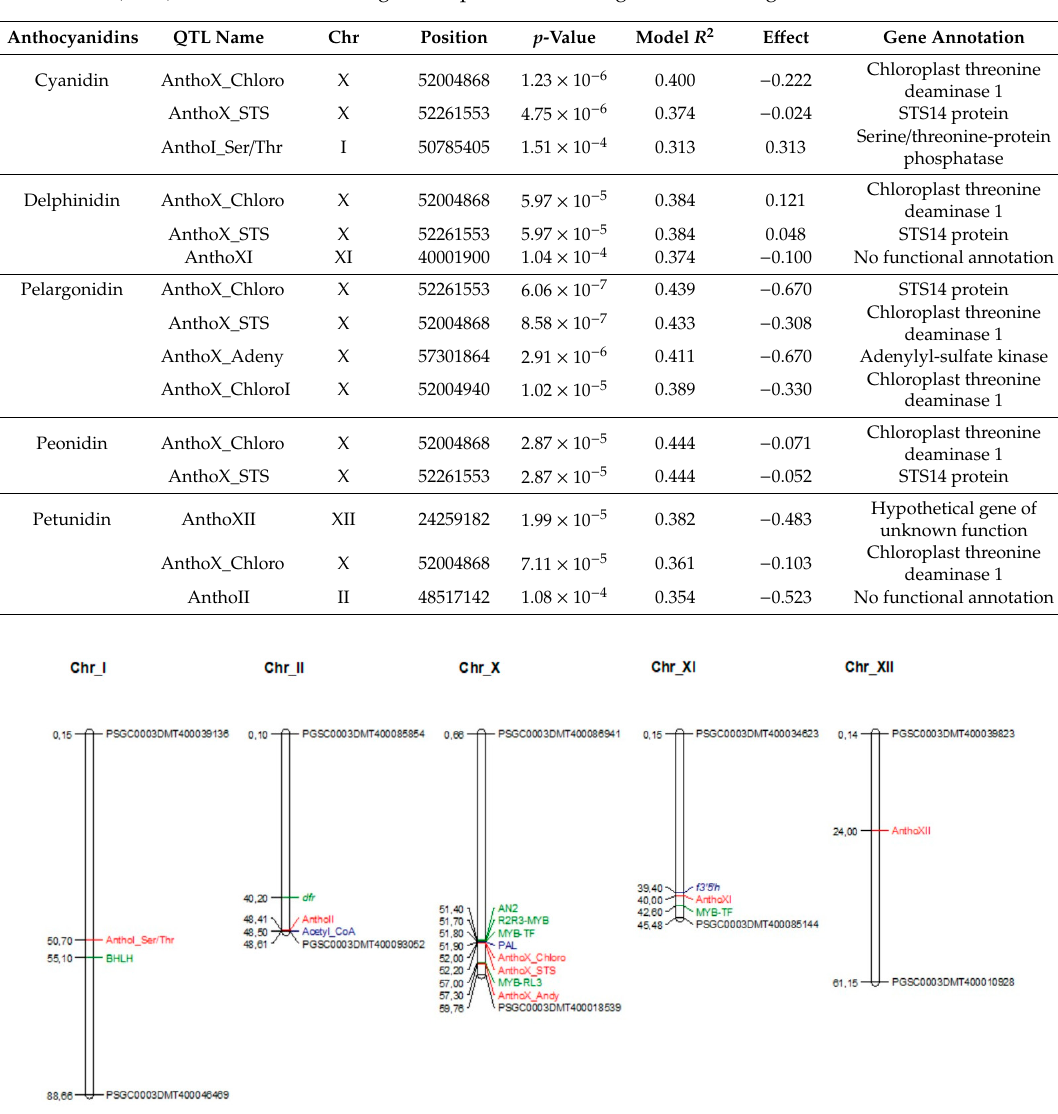
Figure 3. Physical position of Single-nucleotide polymorphisms (SNPs) for anthocyanidin content in cooked tubers of S. tuberosum Group PhurejaIn red it is shown SNP markers significantly associated in this study. In blue genes that are within ± 100 kb of the associated SNPs involved in the anthocyanin biosynthetic pathway. In green other transcription factors and genes reported as associated with the anthocyanin biosynthetic pathway [45,48,49,70]. The genetic distances are given in Mbp, according to the current reference genome DM–v4. Black represents the markers that limit each chromosome in the potato genome. Diagram plotted with MapChart software.